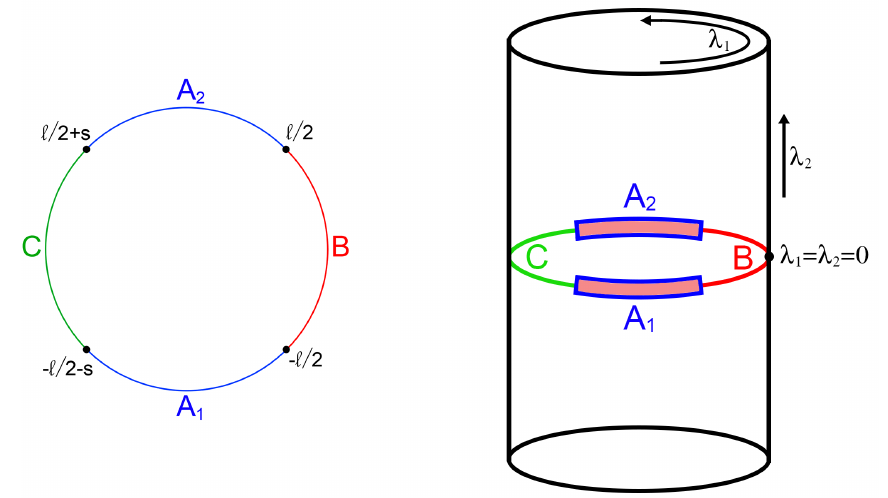
Figure 1 . Left: spatial (constant λ 2 ) slice of the CFT tri-partite system. The regions A , B , C are represented along with the values of λ at their boundaries. Right: Euclidean path integral 1 preparing the post-measurement state of the CFT on a circle at λ = 0 . Conformal boundary 2 conditions are imposed around the slits, which corresponds to having a post-measurement state for the subsystem A given by | ψ i = | B i , where | B i is a Cardy ⊗ | B i A A 1 A 2